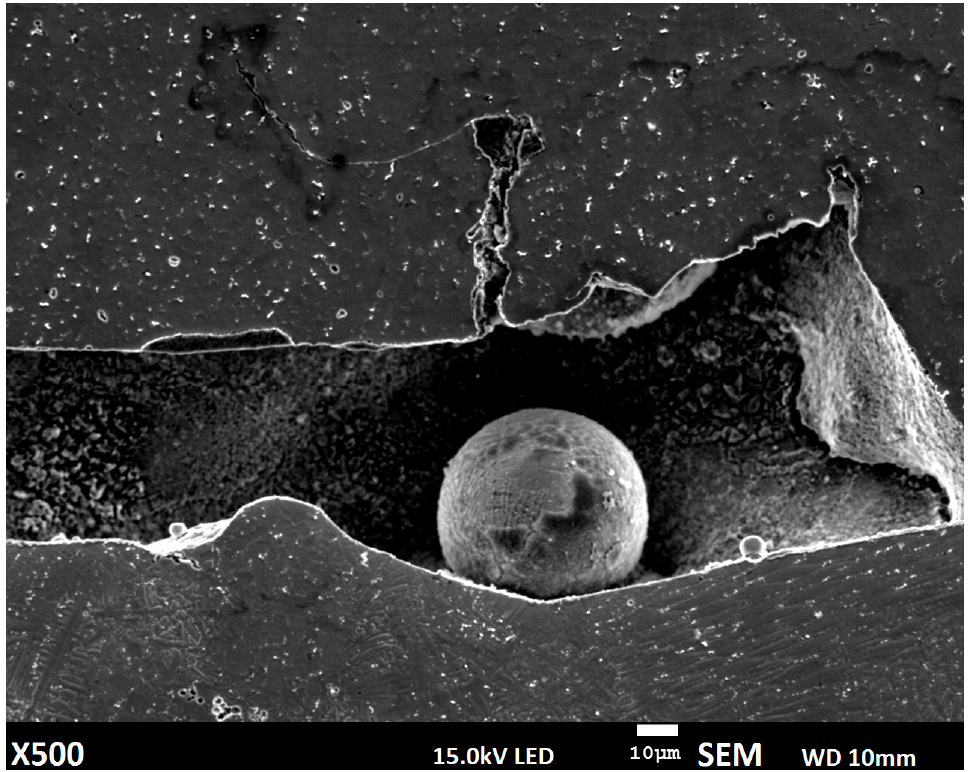
Figure 7. Discontinuities in material manufactured using the powder deposition method.